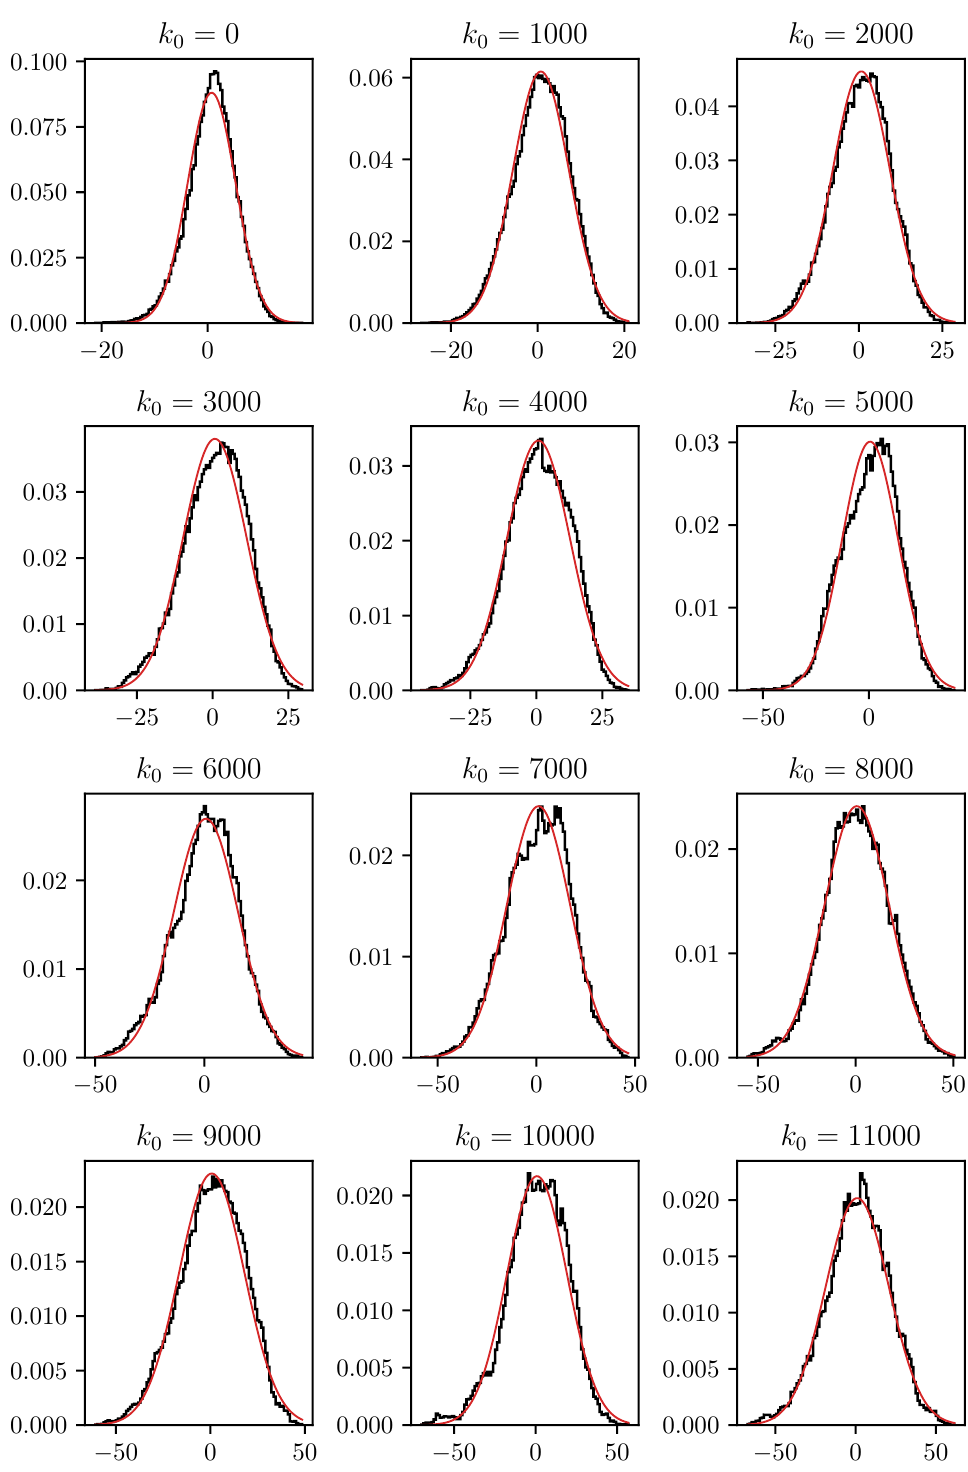
( k ) W ( k ) , for the rectangle billiard in twelve intervals of k . In each Figure 6. Distributions of w , w ( k ) = R ( k ) = N − histogram, there are about 100,000 objects, distributed in 100 bins. The distribution is surprisingly close to Gaussian; there is no significantly nonuniversal distribution for integrable systems. In Table 1, the values of the mean µ , standard deviation σ , skewness, and kurtosis are given. The fitting (red) curve is the Gaussian distribution with the same µ and σ as those obtained. However, the variance as a function of k is linear for all integrable systems; it is thus universal in the class of integrable systems, see Figure